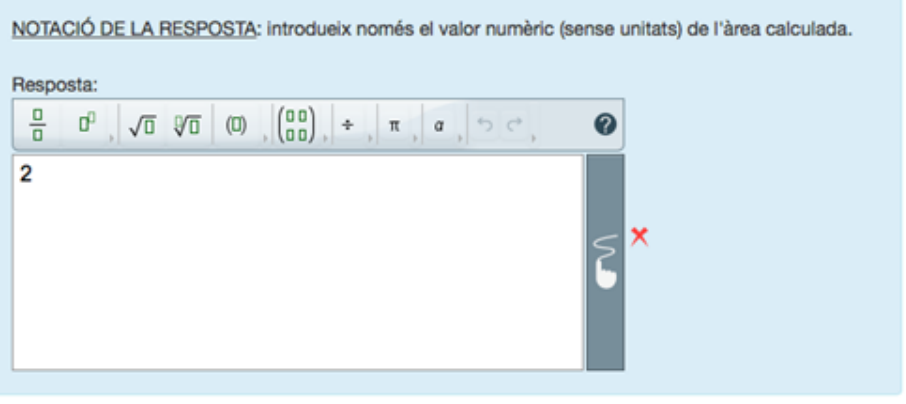
Figure 1. Example of a question of PQ on the topic of definite integrals and areas of regions